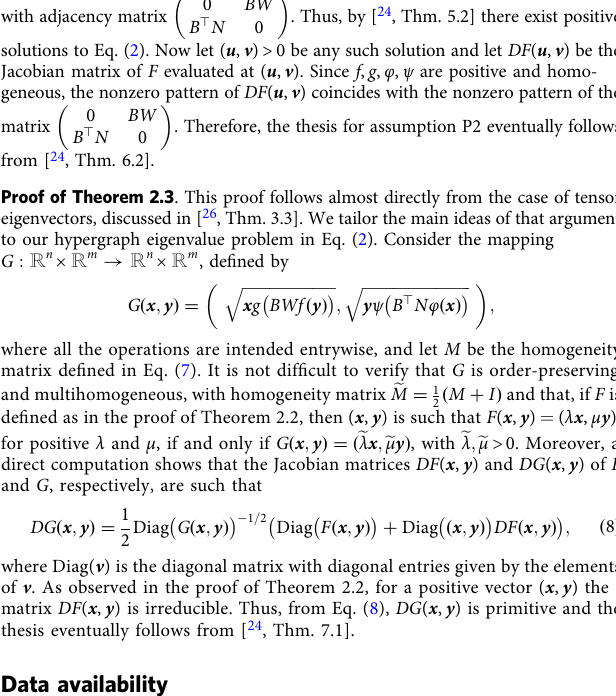
(cid:6)q(cid:3) (cid:4) ffiffiffiffiffiffiffiffiffiffiffiffiffiffiffiffiffiffiffiffiffiffiffiffiffiffiffiffi ffiffiffiffiffiffiffiffiffiffiffiffiffiffiffiffiffiffiffiffiffiffiffiffi (cid:5) (cid:6)q (cid:5) ; y ψ B > N φ ð x Þ x g BWf ð y Þ